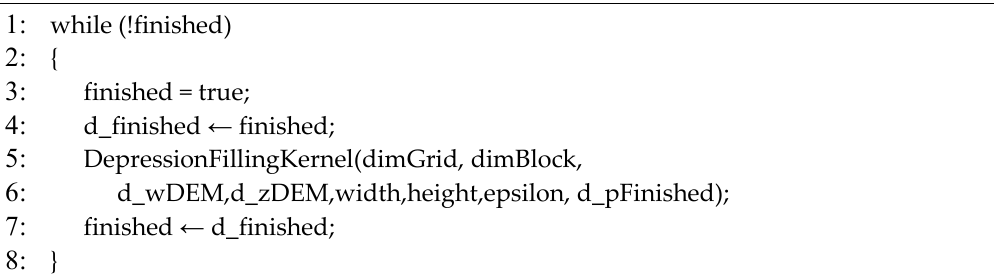
Figure 5. Part of the host pseudo code with the kernel launch.